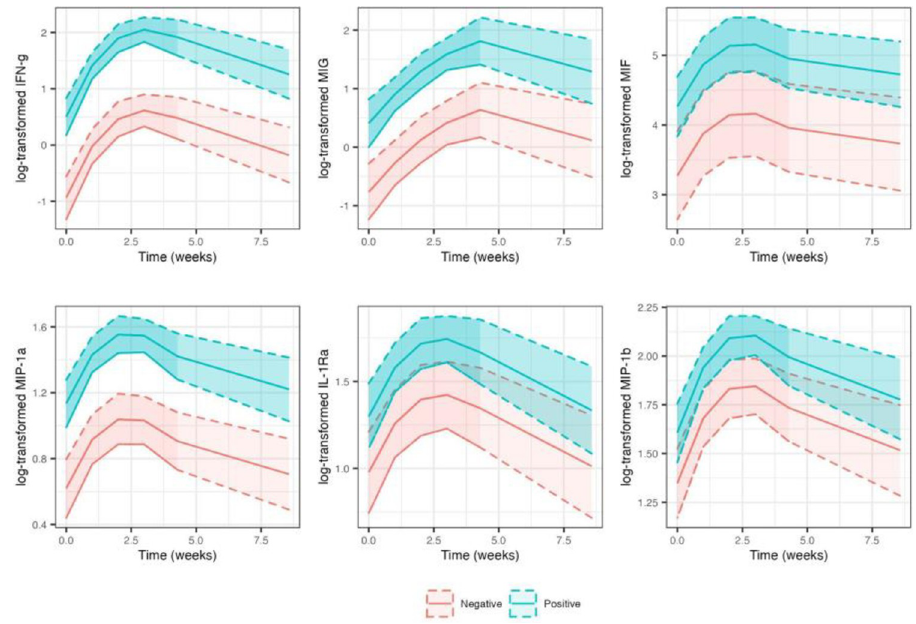
Fig 4. Predicted mean log-transformed cytokine response and 95% confidence band by time (measured in weeks) in animals that tested positive (blue line) versus negative (red line) for M. intracellulare infection based on linear mixed model